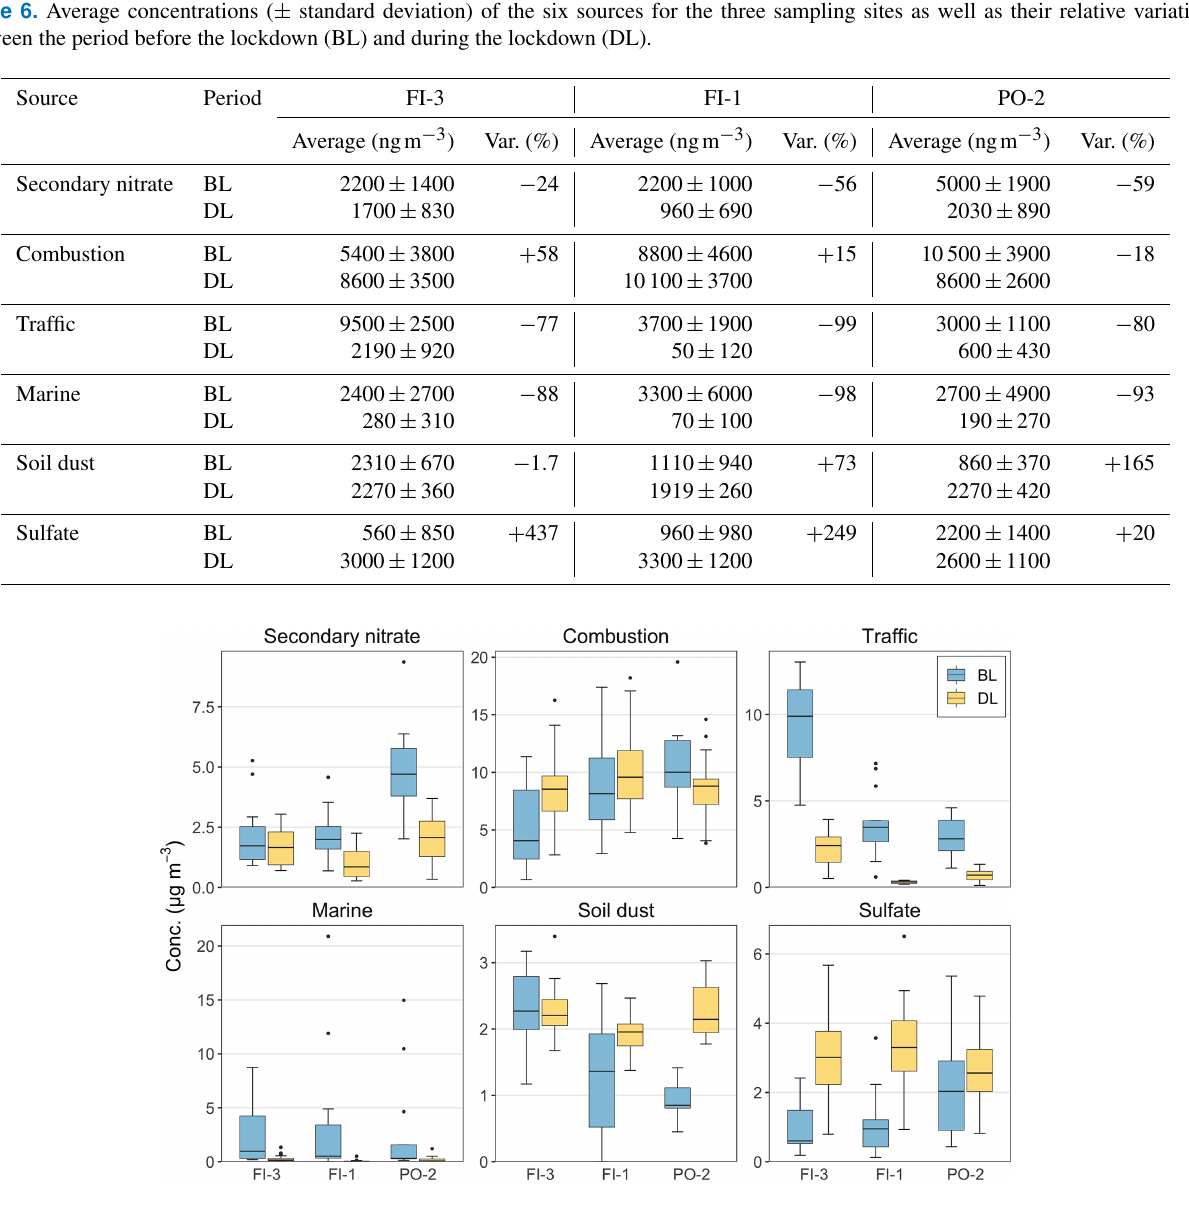
Figure 9. Comparison between the period before the lockdown (BL) and during the lockdown (DL) for each source obtained from the PMF analysis for each of the three sites. Boxes represent the interquartile range (IQR; between the 25th and 75th percentile) and the median (line inside the boxes), whiskers cover the range of the samples over and under 1 . 5 · IQR, and the points are